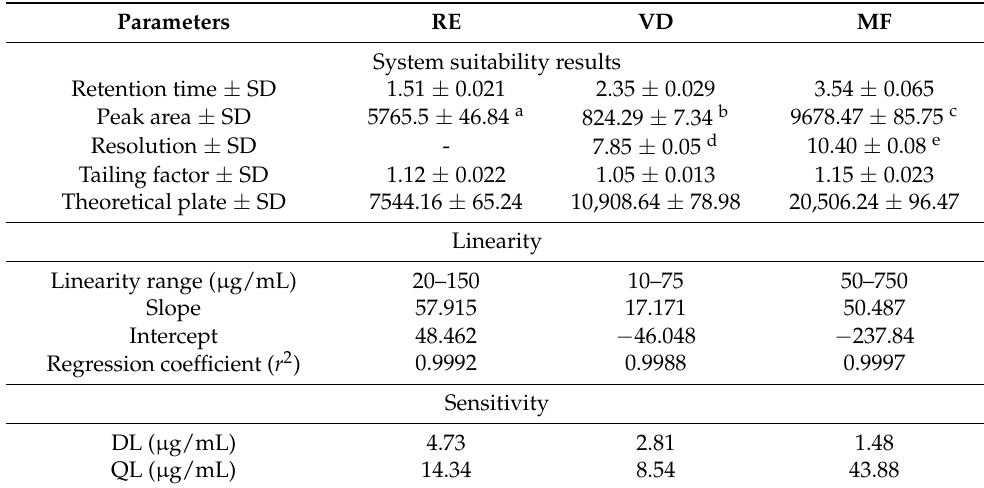
Table 3. System suitability and regression analysis